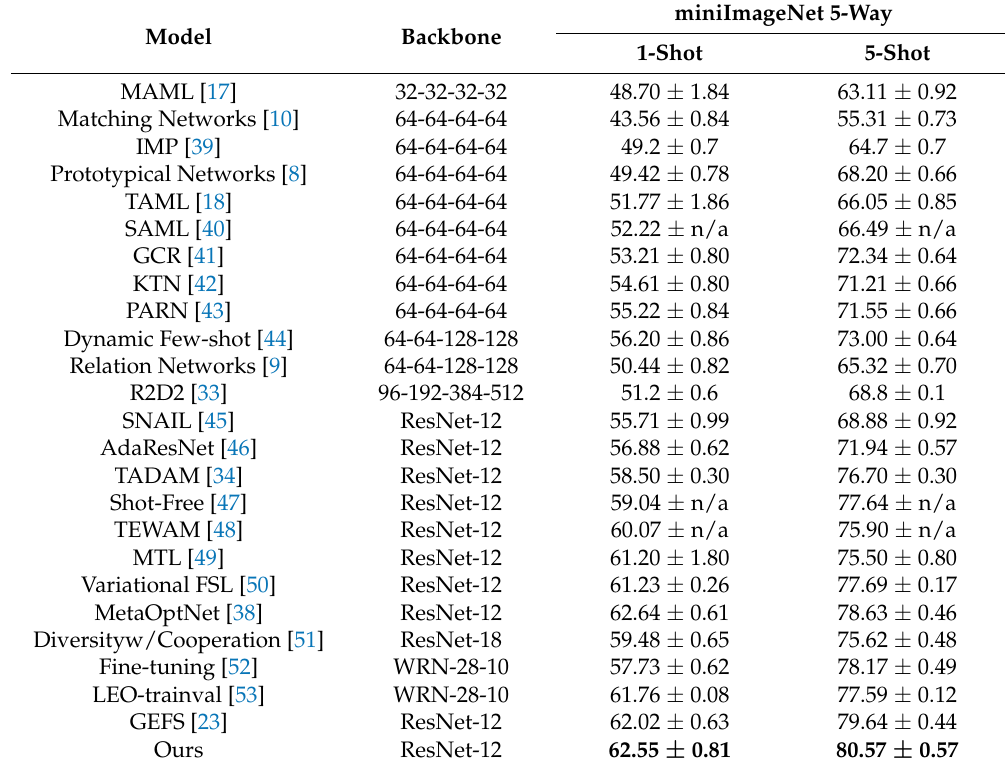
Table 1. Experiments were conducted on the miniImageNet dataset and our approach was compared with existing methods. Average meta-learning classification accuracies (%) with 95% confidence intervals on miniImageNet meta-test splits. a-b-c-d denotes the size of the layer in the